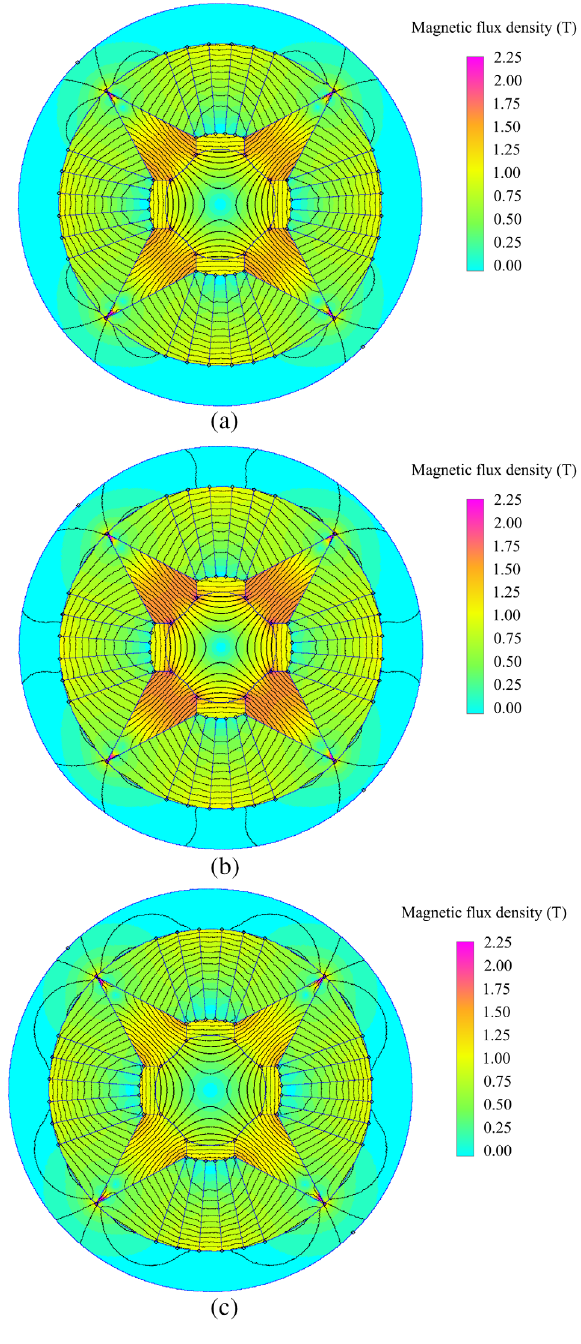
FIG. 9. Magnetic field in the hybrid design when adjusting excitation current. (a) Zero current; (b) Maximum current density 50 A = mm 2 ; (c) Maximum opposing current density − 50 A = mm